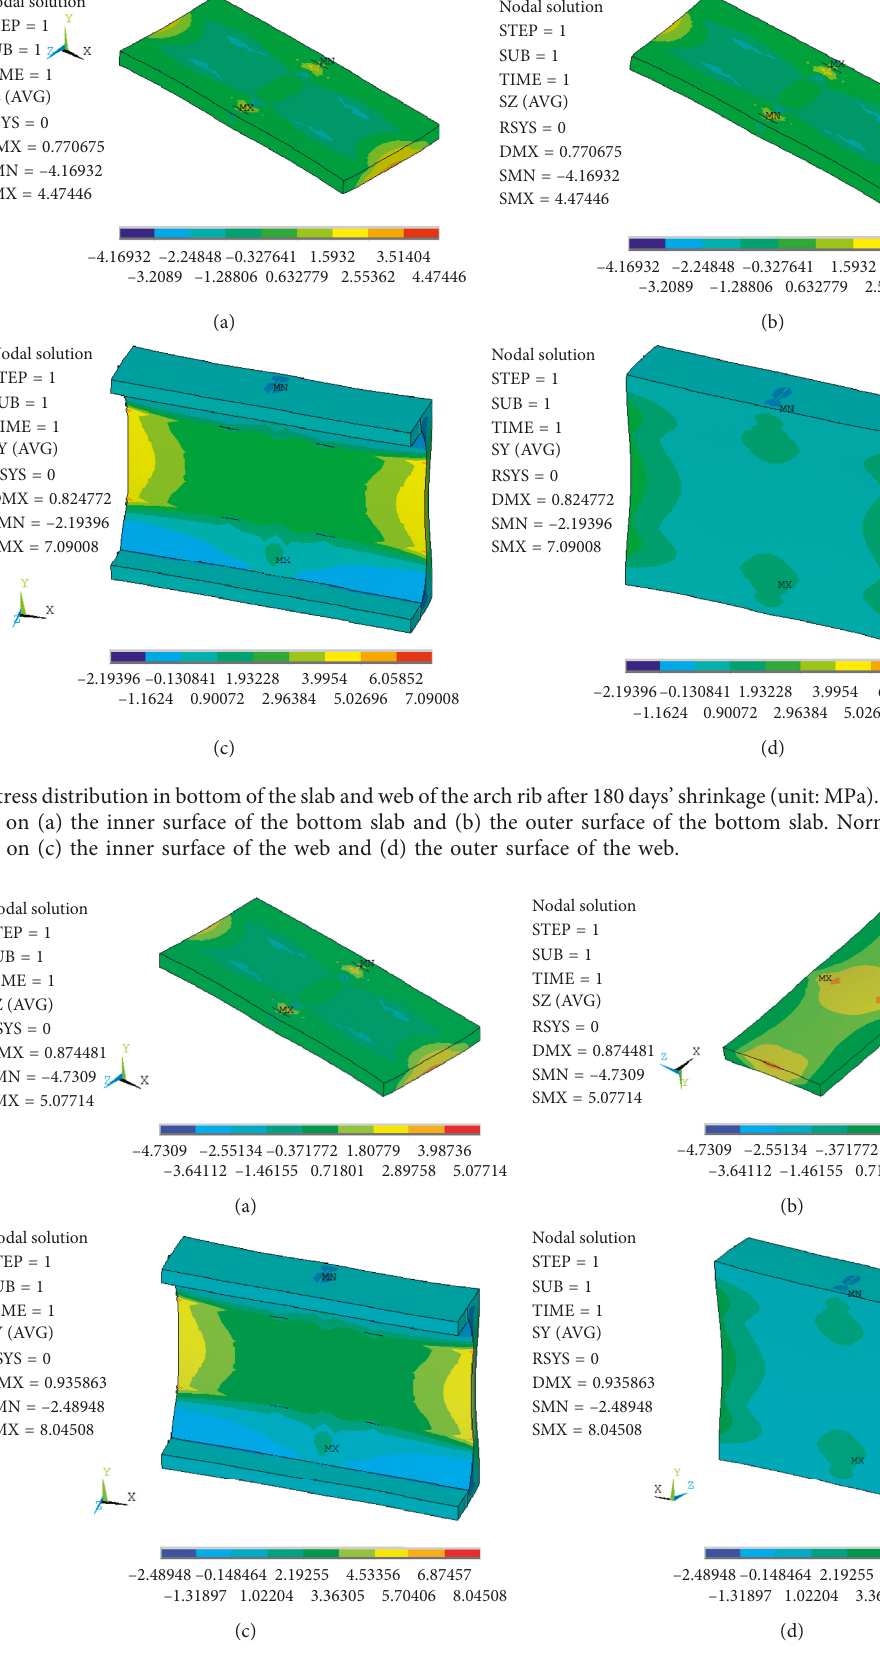
Figure 9: Stress distribution in bottom of the slab and web of the arch rib after 3600 days’ shrinkage (unit: MPa). Normal stress distribution in Z -direction on (a) the inner surface of the bottom slab and (b) the outer surface of the bottom slab. Normal stress distribution in the Y - direction on (c) the inner surface of the web and (d) the outer surface of the